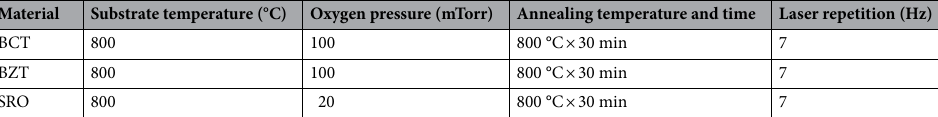
Table 1. Optimized deposition parameters for the epitaxial growth of different materials.